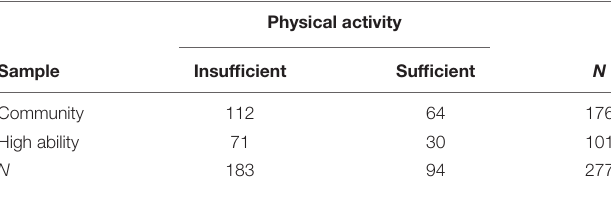
TABLE 5 | Perception of the adequate physical activity developed by their children.